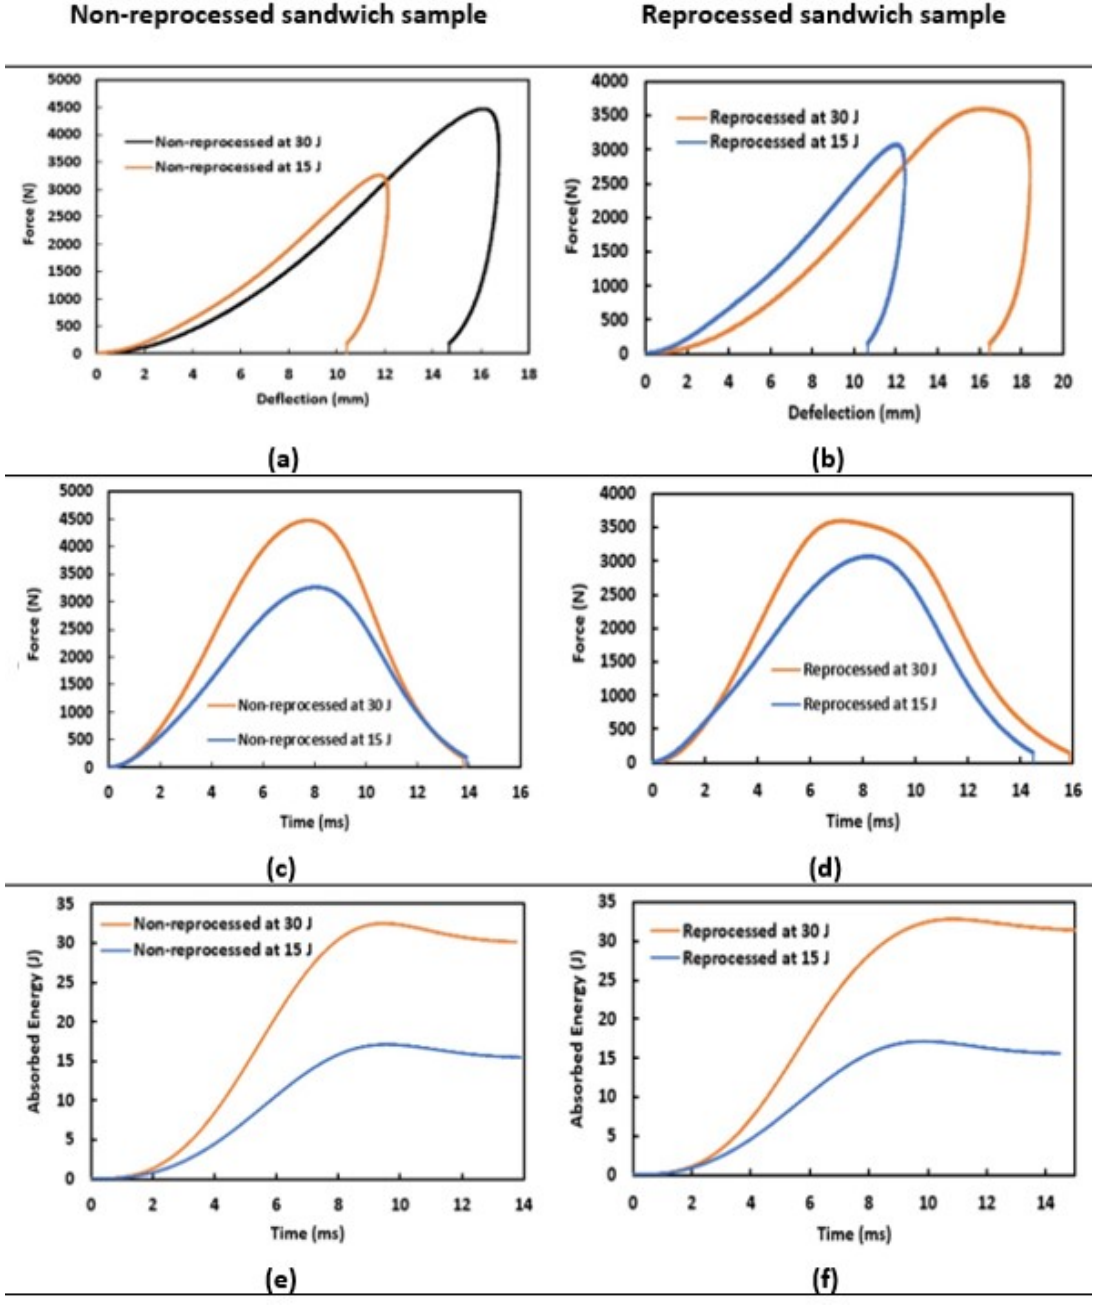
Figure 3. Low-velocity impact properties. ( a ) Force-deflection, ( c ) force-time, and ( e ) absorbed energy-time of non-reprocessed and ( b ) force-deflection, ( d ) force-time, and ( f ) absorbed energy-time of reprocessed sandwich structures.